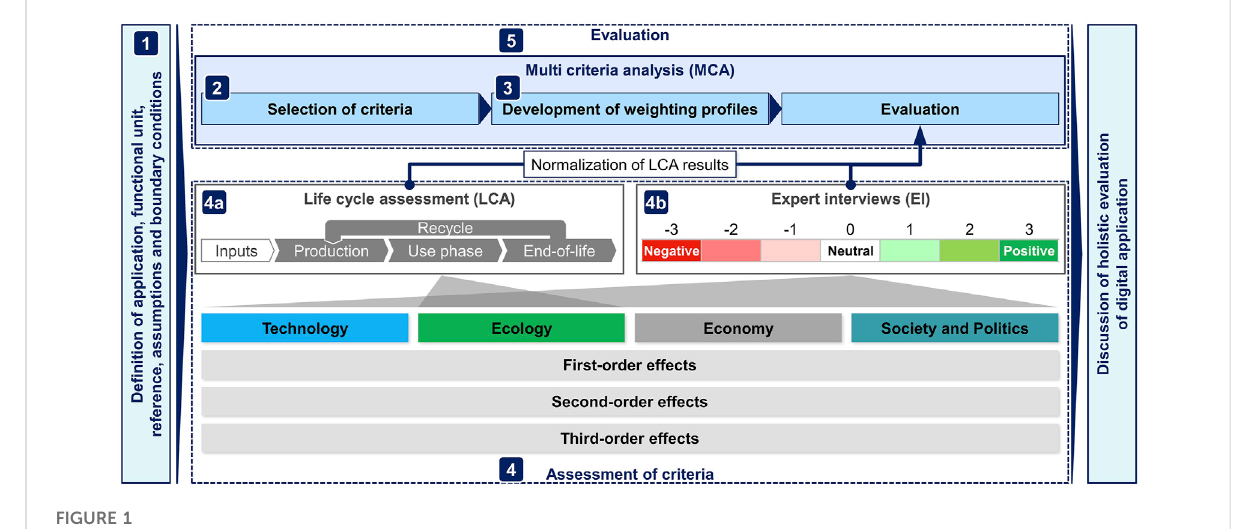
FIGURE 1 Modi fi ed multi-method framework for evaluating digital applications in the energy sector, based on (Weigel et al.,